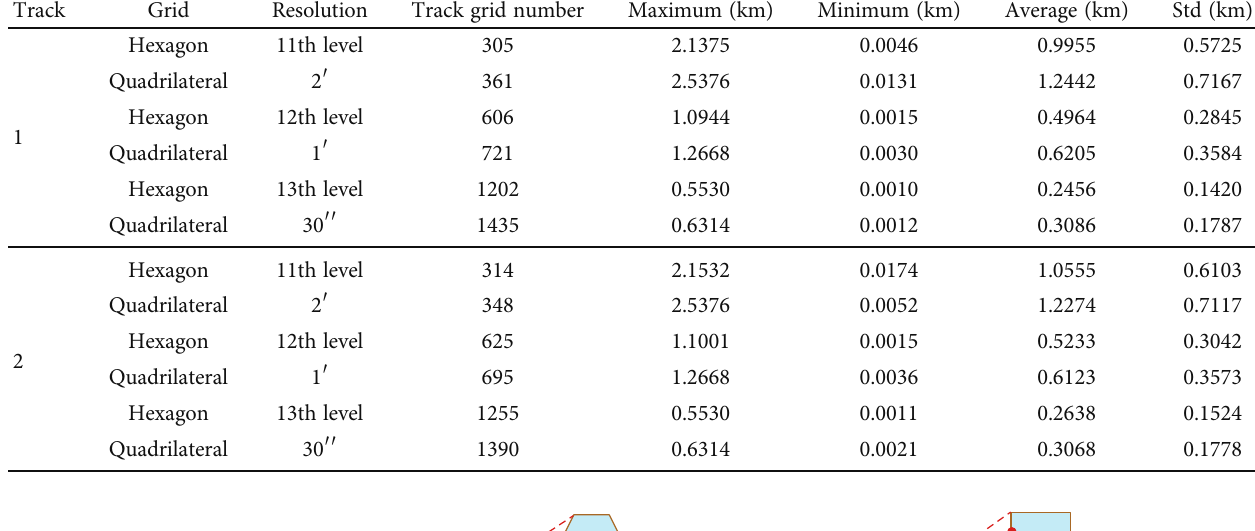
Table 5: Grid model error statistics, where Std indicates the standard deviation.